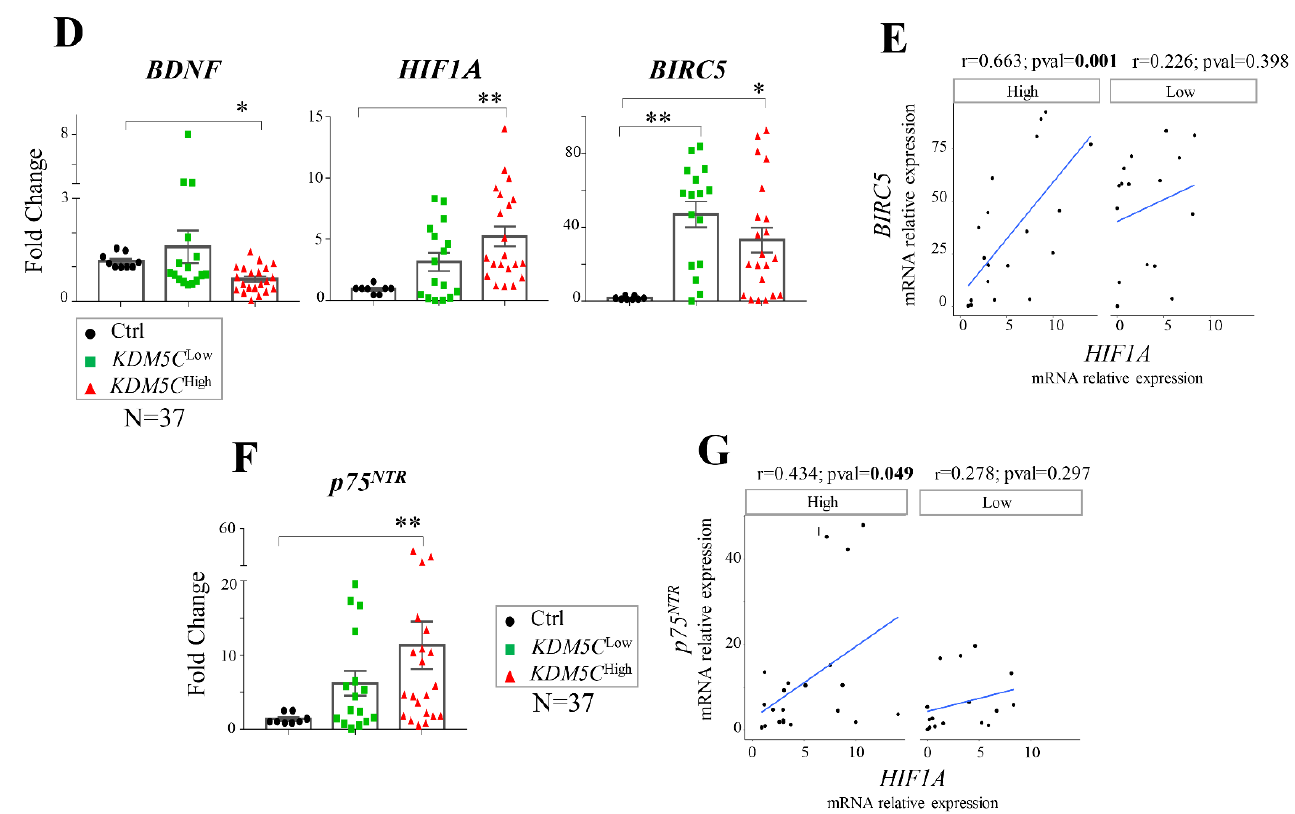
Figure 1. Expression analysis in KDM5C Low and KDM5C High cohorts. ( A ) Analysis of KDM5C expression by real-time PCR (RT-PCR) assay and ( B ) Western blotting. ( C ) Ki67 expression analysis in GBM patients with (Epilepsy+) or without epilepsy (Epilepsy − ), and p53 expression analysis in GBM patients with wild-type (WT) or mutated IDH1/2 (mut) alleles. ( D ) RT-PCR analysis of BDNF , HIF1 A, and BIRC5 . ( E ) Scatter plots reporting the correlation—by linear regression analysis—of HIF1A and BIRC5 expression in the KDM5C Low and KDM5C High subgroups. ( F ) RT-PCR analysis of p75 NTR expression in healthy controls, KDM5C Low , and KDM5C High GBM samples. ( G ) Scatter plot reporting the correlation—by linear regression analysis—of HIF1A and p75 NTR expression in the KDM5C Low and KDM5C High subgroups. Each transcript analysis was performed in triplicate, and the samples were normalized with the TATA-Box Binding Protein ( TBP ) transcript. The bars indicate the mean ± SEM of repeated experiments. Asterisks indicate statistical significance compared with healthy control samples: *** p < 0.0005, ** p < 0.005, and * p < 0.05. The Western blotting experiment was repeated in triplicate, and the beta-actin antibody ( β -ACTIN) was used as a loading control. In the scatter plots, the average expression value of healthy control samples was used as a